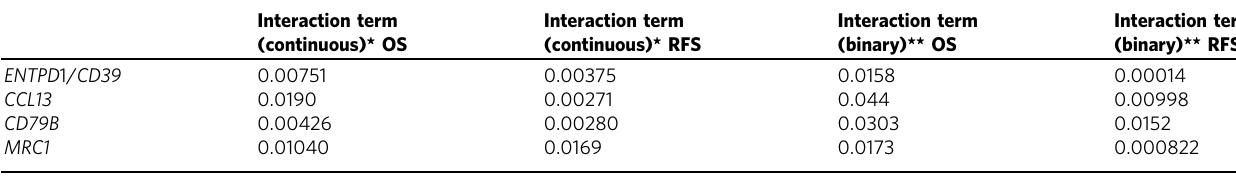
*Analyzed with genes as raw continuous data. **Analyzed with genes dichotomized.